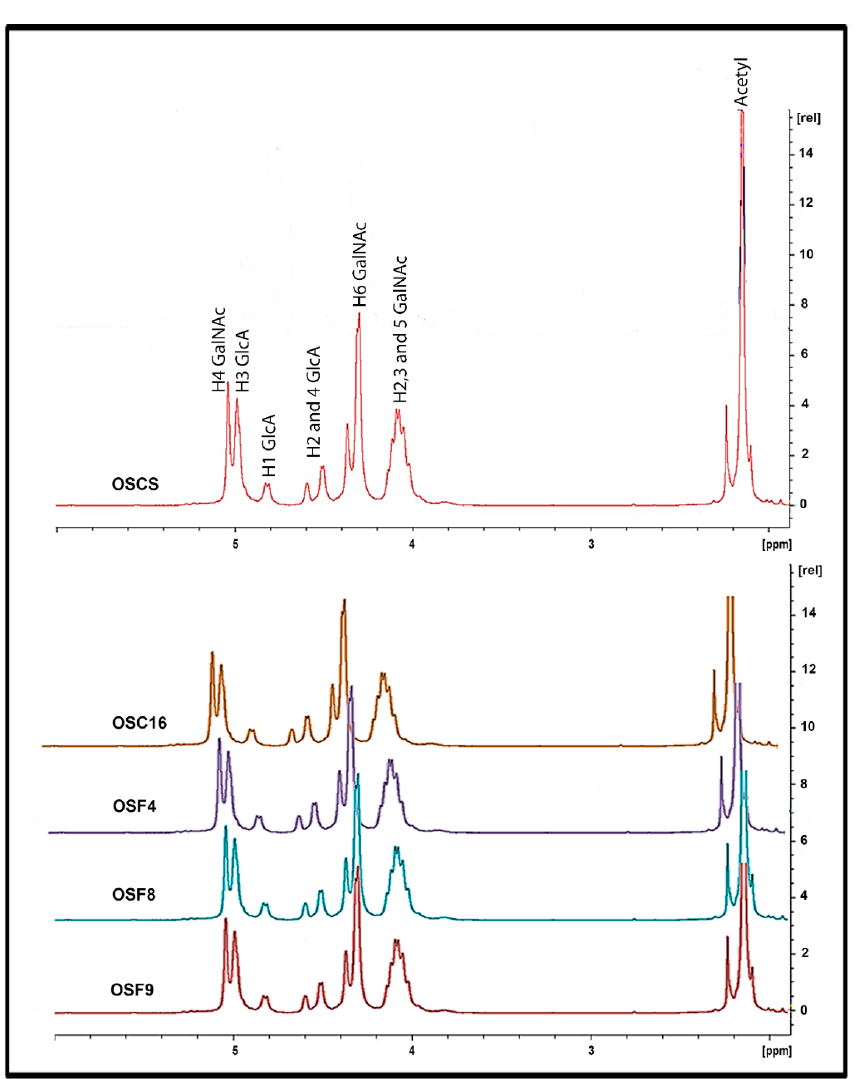
Figure 5. 1 H-NMR spectra of standard OSCS and sulfated contaminants isolated from crude (OSC16) and final heparin samples (OSF4, OSF8 and OSF9). The isolated contaminants purified from crude and final heparin batches were structurally characterized by nuclear magnetic resonance ( 1 H NMR). Solutions of 20 mg/mL of each sample in deuterium oxide (99.9%) were analyzed for the acquisition of free induction decay (FID) using 16 scans, 90° pulse and 20 s delay at 37 °C in a Bruker Spectrometer DRX-500. Sulfated contaminants purified from batches of crude (OSC16) and final heparin (OSF4, OSF8 and OSF9) display similar 1 H NMR spectra of standard OSCS.